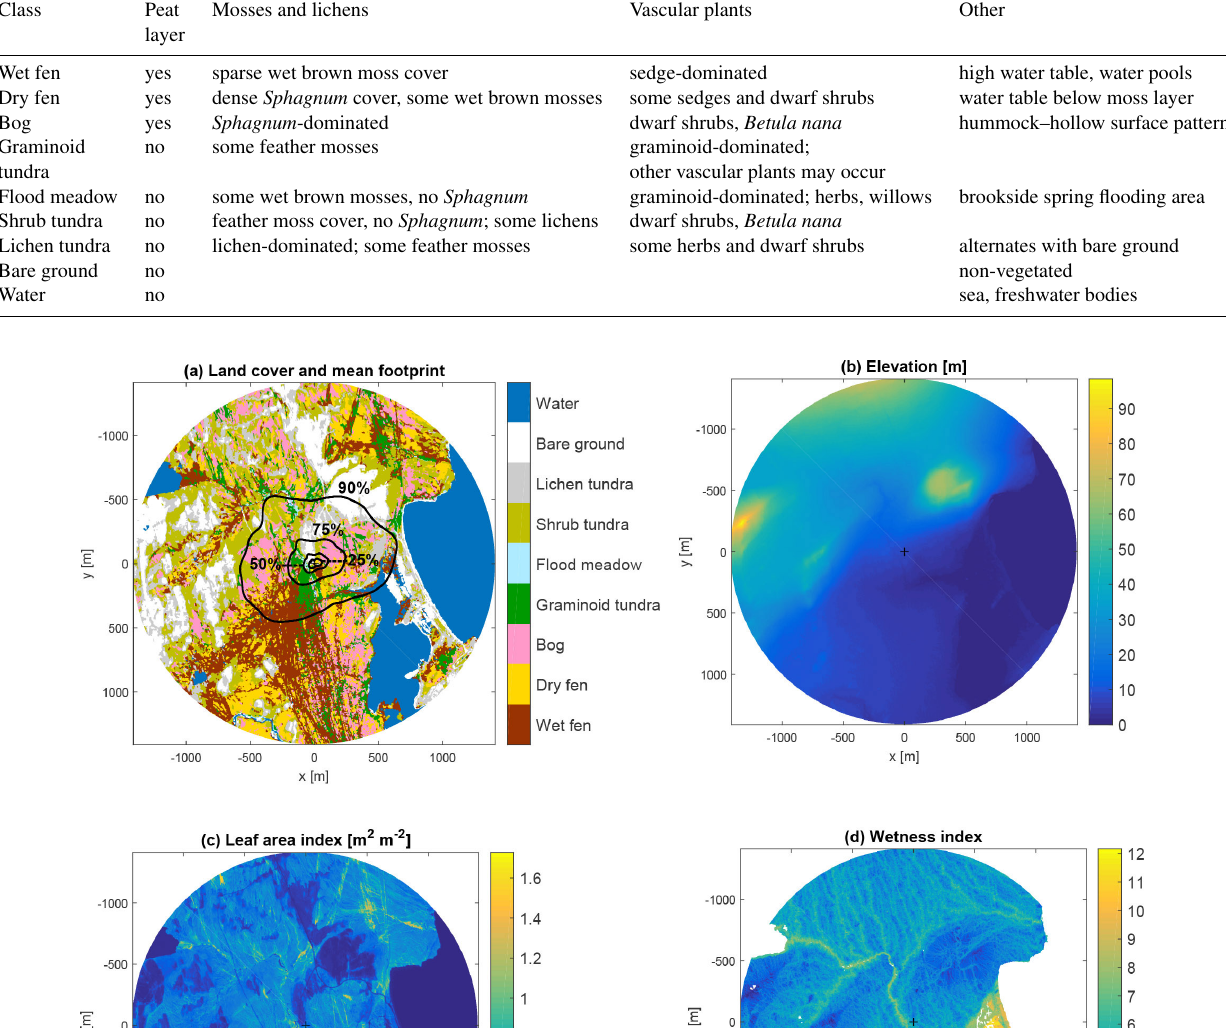
Table 1. Land cover classes and their dominating vegetation and other characteristics, derived from Juutinen et al. (2017) and Mikola et al. (2018).